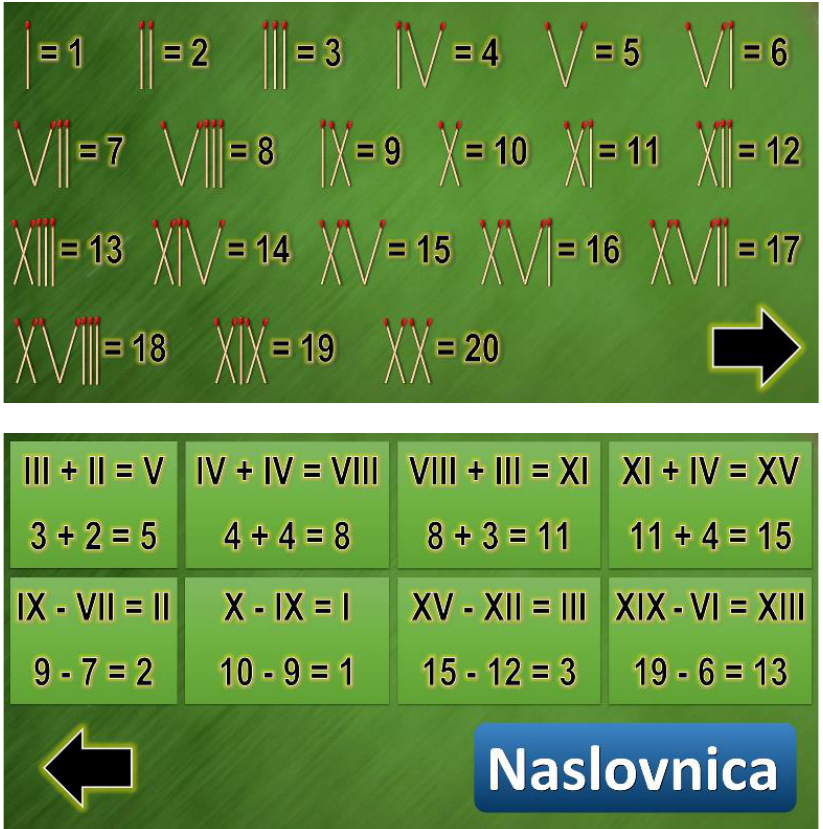
Fig. 1. Instructions and teaching materials in the game for learning arithmetic operations with Roman